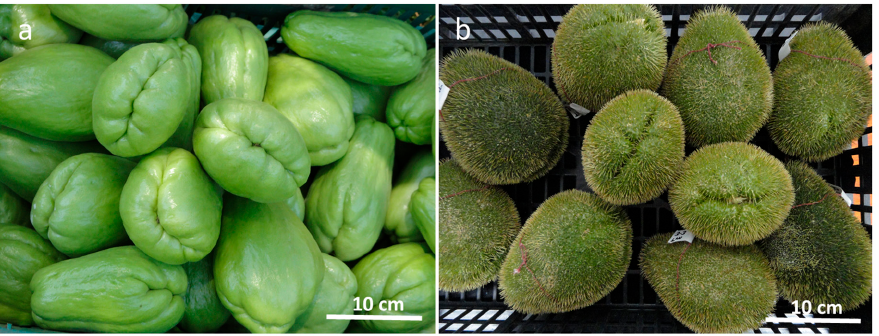
Figure 1. Varieties of chayote ( Sechium edule ) from Veracruz, México. ( a ) virens levis (VL) and ( b ) nigrum spinosum (NS).